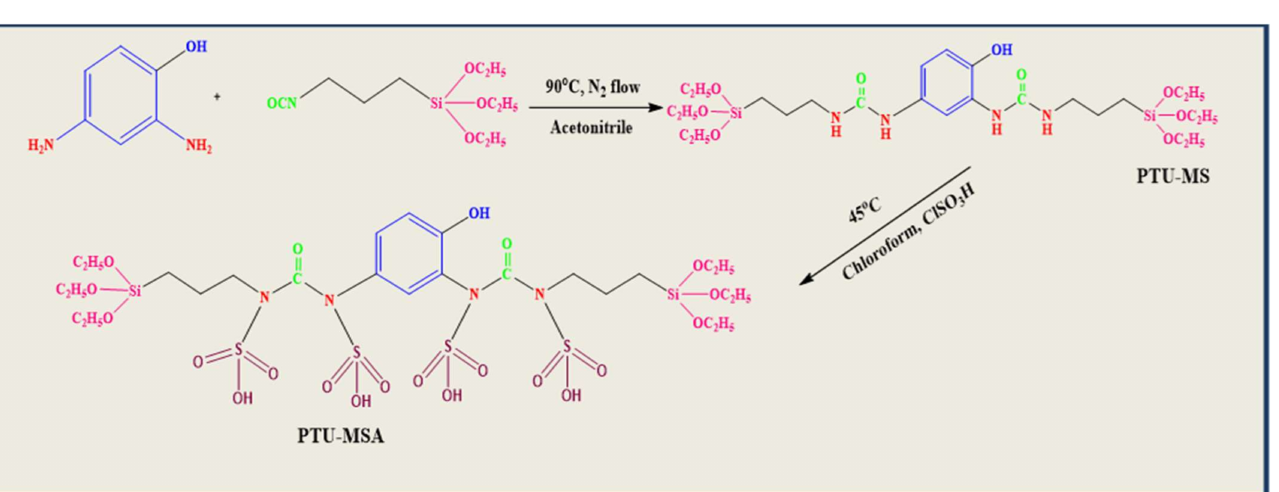
Figure 14. Preparation of PTU-MS and